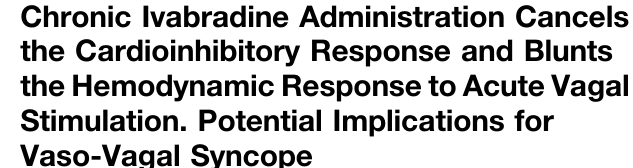
Frontiers in Pharmacology |